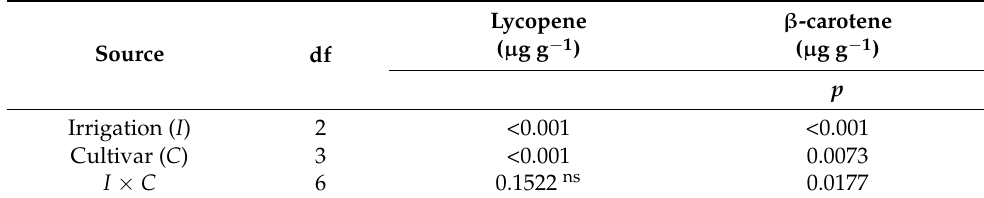
Table 4. ANOVA results for lycopene and β -carotene content in four cultivars of tomato in relation to the irrigation treatments. Degree of freedom (df); ns (not significant).